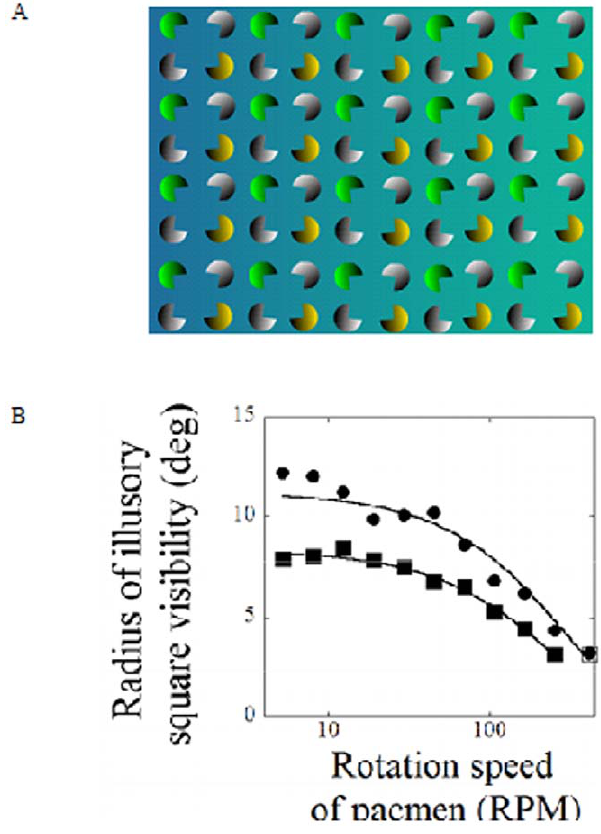
Figure 6. The Disappearing Squares illusion (see Movie S5). A) A 16 6 12 array of Kanizsa pacmen rotate in opposite directions so as to continually assemble/disassemble arrays of Kanizsa squares. B) Two observers adjusted the radius of the circles to encompass the range of visible squares as a function of rotation rate of the pacmen. The results for each observer are indicated by the squares and filled circles. As the rotation rate increases, the peripheral range over which the illusory squares can be seen